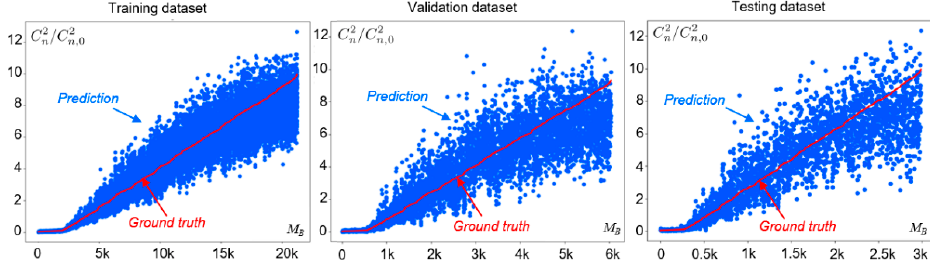
Figure 7. Exemplary scatterplots illustrating predicted C 2 n values for DNN model training ( left ), validation ( middle ), and testing ( right ) vs. DNN input sequence number M B in the corresponding subset of the TurbNet-LED dataset ( M B = 1.0K corresponds to 10 3 input sequences and = 1.0 · 10 − 15 m − 2/3 ). The corresponding results for DNN training, validation, and testing on the TurbNet-LB dataset are similar and, therefore, are not presented.